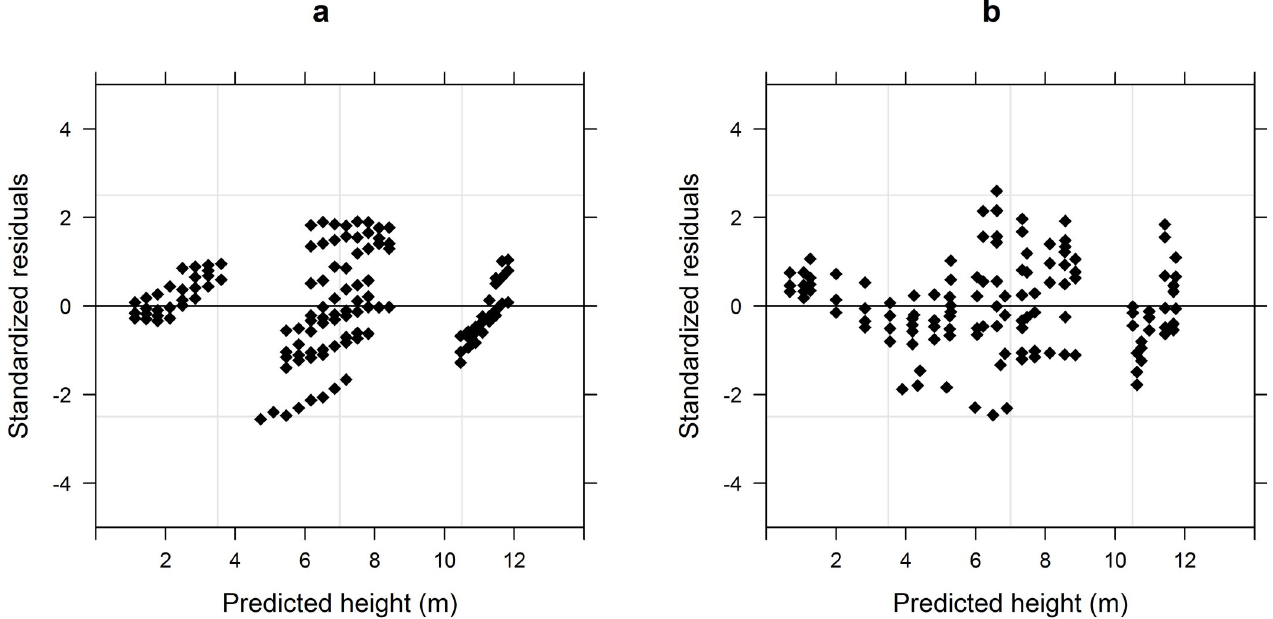
Fig 2. Distributions of standardized residuals. (a) Basic model. (b) Generalized model. https://doi.org/10.1371/journal.pone.0213509.g002 goodness-of-fit increased significantly (P < 0.001) (Table 5). The constant plus power function (Eq (3.3)) yielded maximal changes in AIC, BIC, and LL, and this variance function was finally selected to eliminate heteroscedasticity, which was effective as indicated by the uniform distri- bution of the model’s standardized residuals after this treatment (Fig 3B).